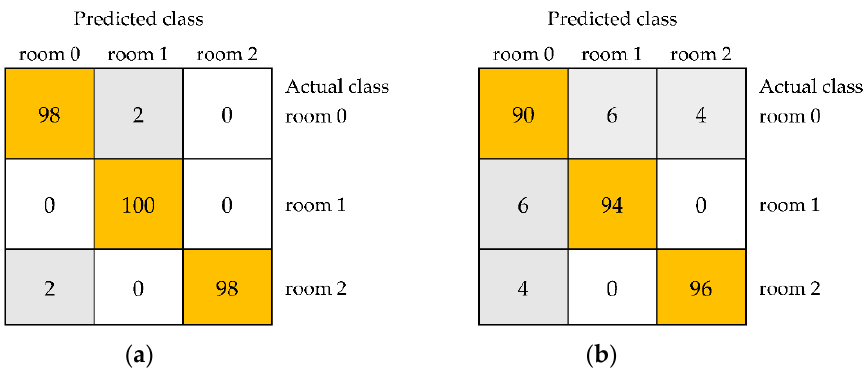
Figure 6. The confusion matrices of distinguishing unstored black currants (room 0) and samples stored in the room for 1 week (room 1) and 2 weeks (room 2) using models combining selected image textures from color space XYZ developed using random forest ( a ) and multiclass classifier ( b ).